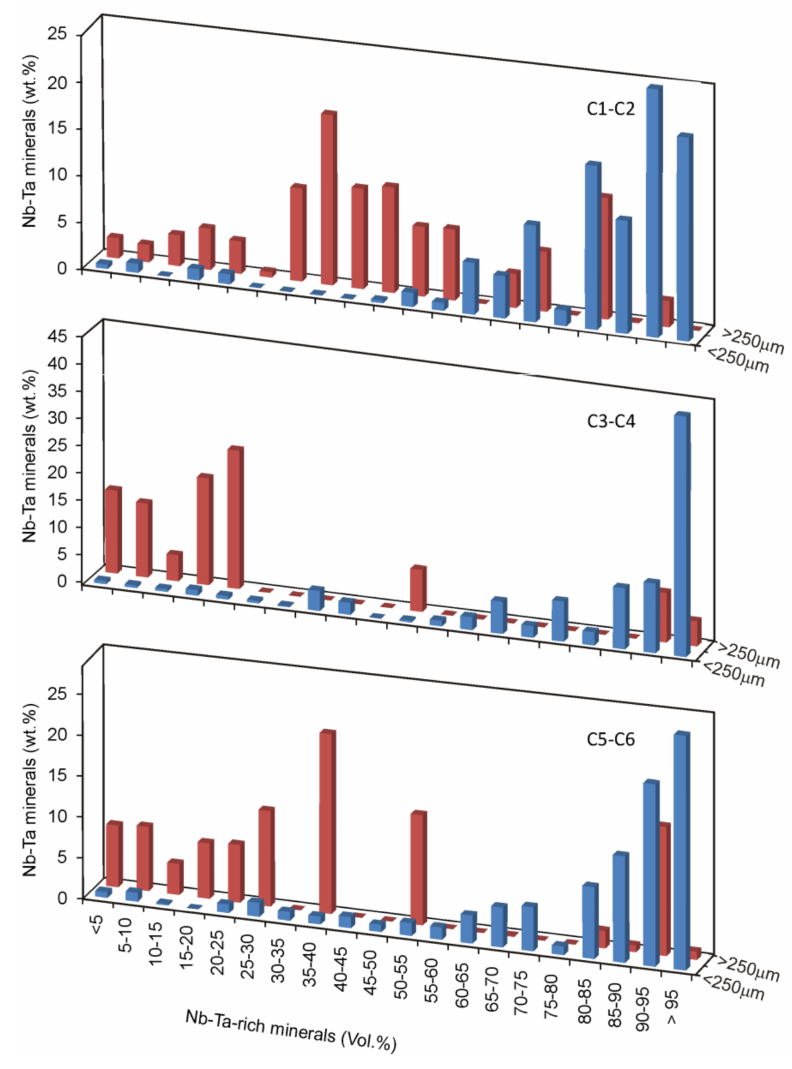
Figure 11. Distribution of the Nb-Ta-rich minerals in the concentrate material from the Penouta open pit according to particle size and grade classes. Table 5. Liberation of cassiterite and CGM from the Penouta open pit leucogranite. Grade is reported in volume % and minerals content in wt